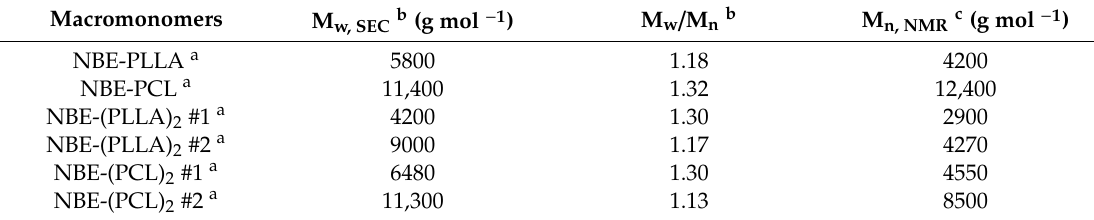
Table 1. Molecular characteristics of the norbornenyl